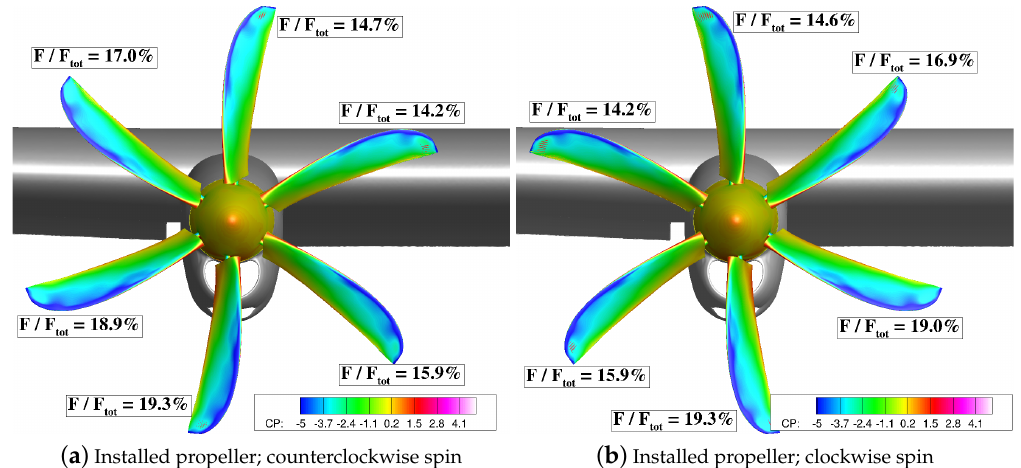
Figure 5. Installed propeller surface pressure data. Propeller installed inboard; propellers have a 20-deg blade angle and spin at 1024 rpm clockwise or counterclockwise. Propeller solutions are at final simulation